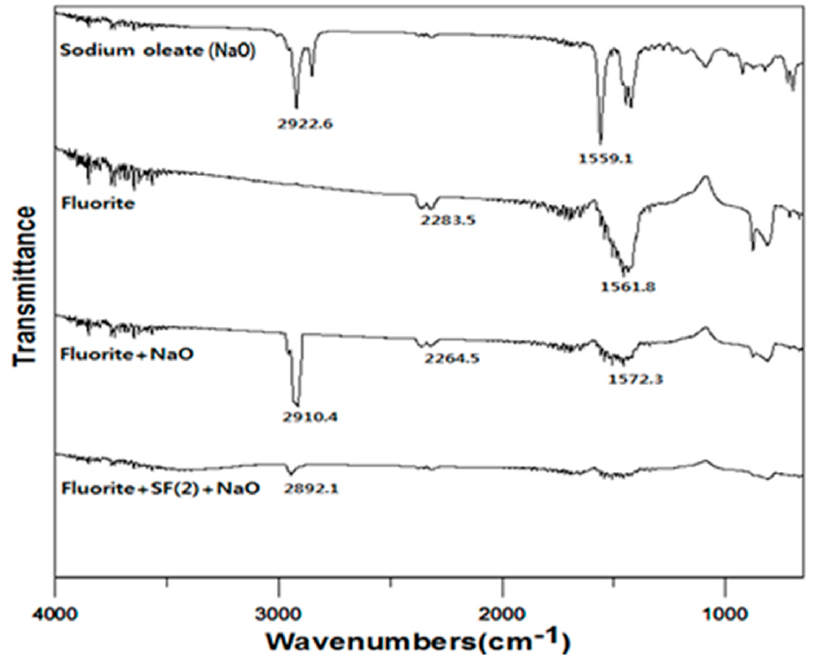
Figure 11. FTIR analysis result of fluorite at the optimum flotation conditions.